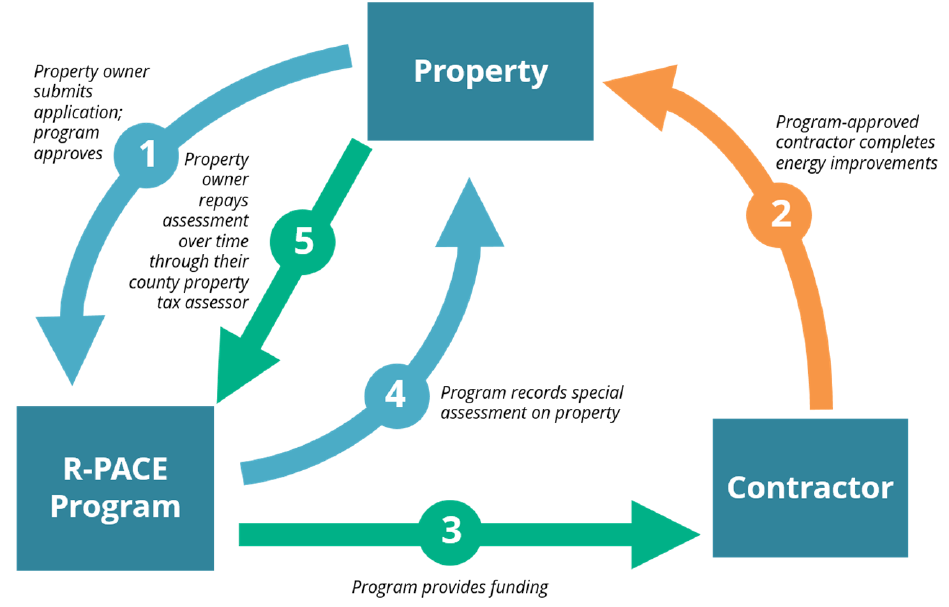
Figure 1. Overview of the R-PACE project process.